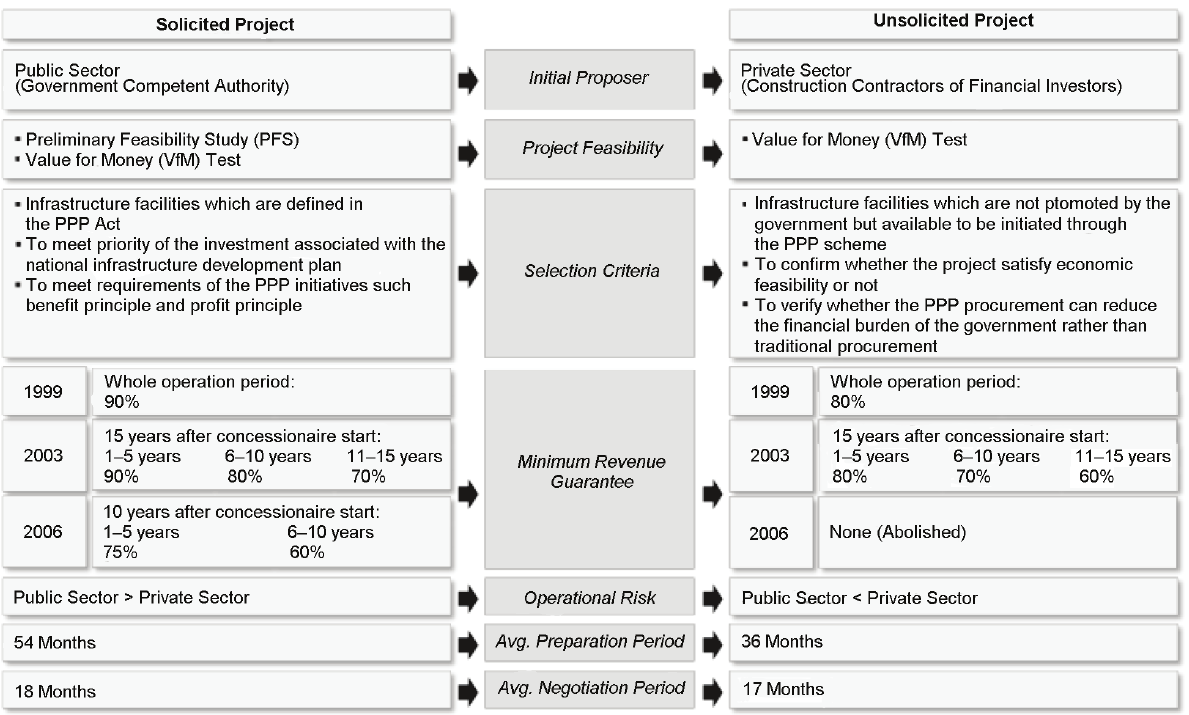
Fig. 1. Comparison of characteristics of solicited and unsolicited